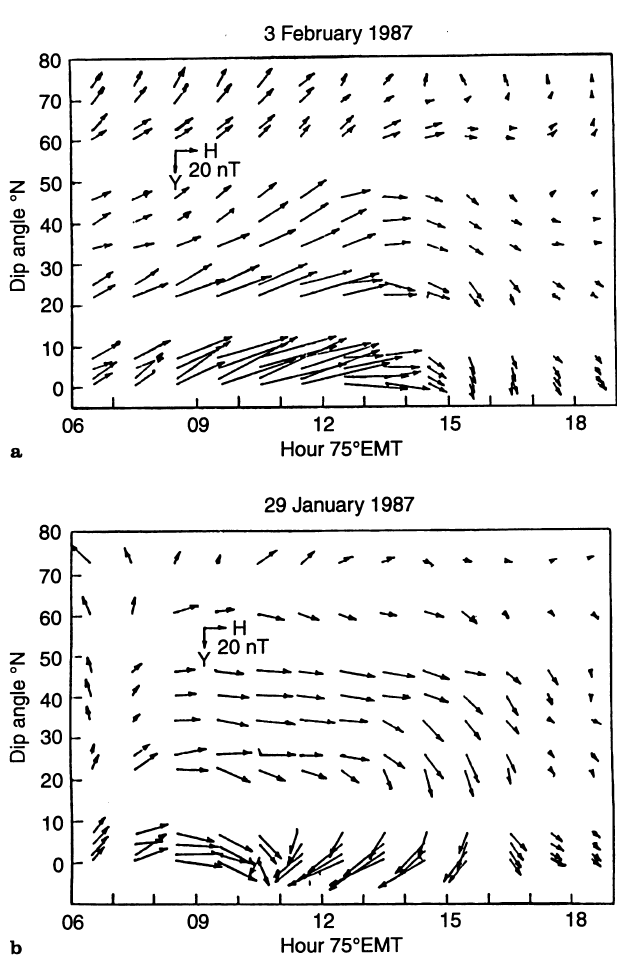
Fig. 8. a The current vectors at di(cid:128)erent stations at each hour during daytime on 3 February 1987 a normal electrojet day; b the current vector at di(cid:128)erent stations at each hour during daytime on 29 January 1987, a counter